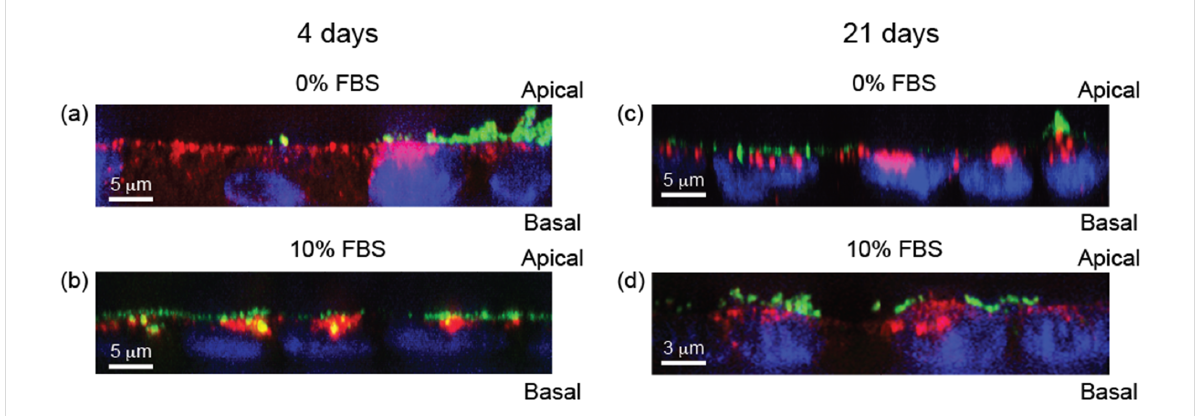
Figure 2: Confocal fluorescence cross-section images of Caco-2 barriers exposed to 50 nm SiO 2 -NPs. Caco-2 barriers cultured for 4 (a,b) and 21 days (c,d) were exposed for 6 h to 100 µg/mL 50 nm SiO 2 -NPs in the absence of serum (0% FBS; a and c) and presence of serum (10% FBS; b and d). The nanoparticles are shown in green. Lysosomes and nuclei were stained by Lysosomal-Associated Membrane Protein 1 (LAMP1) anti- body (red) and DAPI (blue), respectively.